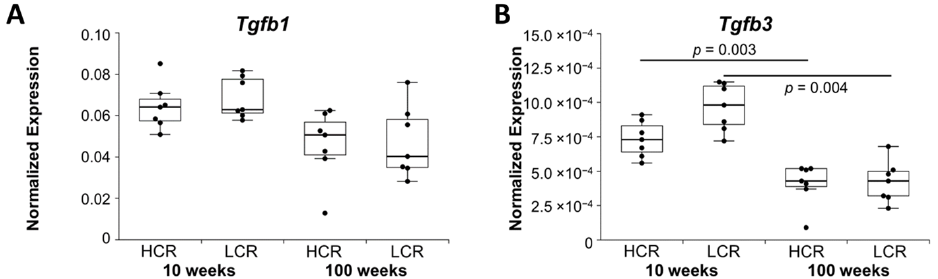
Figure 3. Normalized expression (NE) of ( A ) transforming growth factor beta 1 and ( B ) beta 3. qRT-PCR data were normalized to the expression of the house keeping gene Rps18 . Results are shown as box plots with individual data points. Significant differences between two groups are marked as a line spanning between them with the p -value displayed above. p ≤ 0.05 was considered statistically significant.